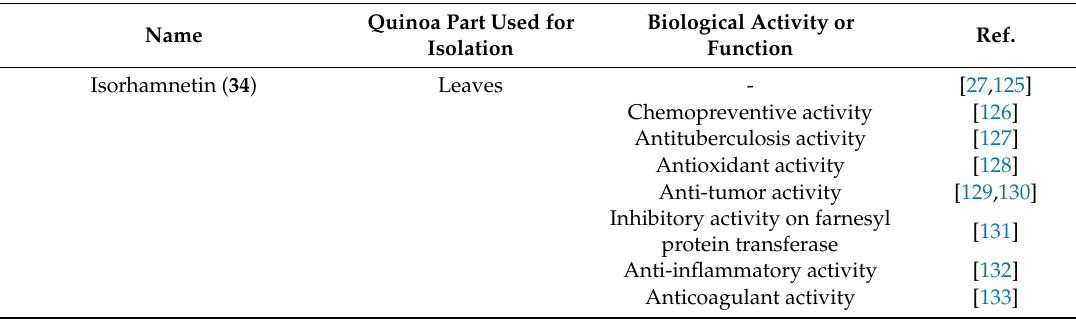
Table 4. Flavonols and their biological activities or